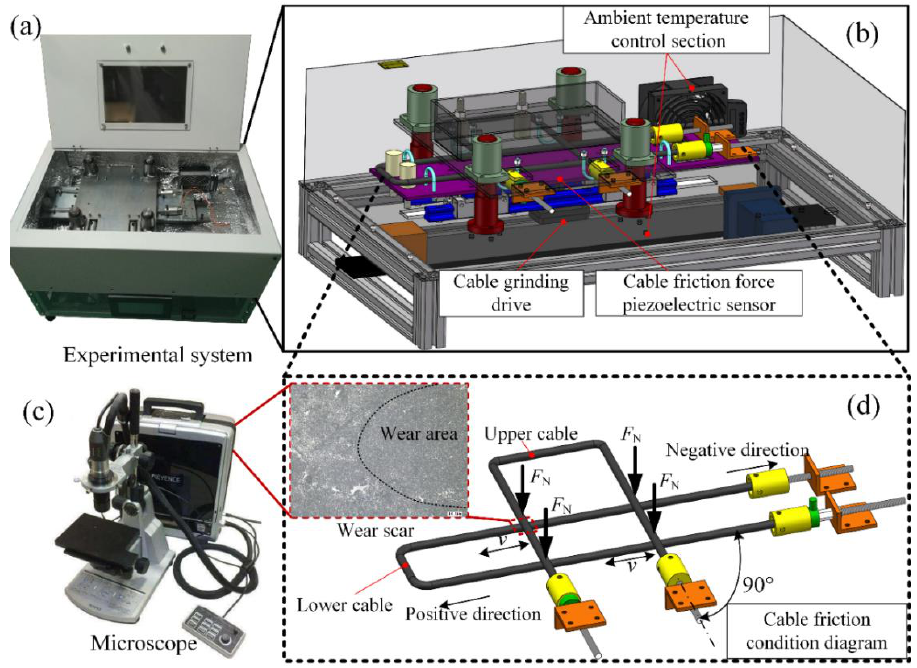
Figure 1. Physical system schematic diagrams of the experimental system, ( a ) friction and wear tester; ( b ) functional model diagram of the friction and wear tester; ( c ) the microscope; ( d ) schematic diagram of the flexible cable friction form.